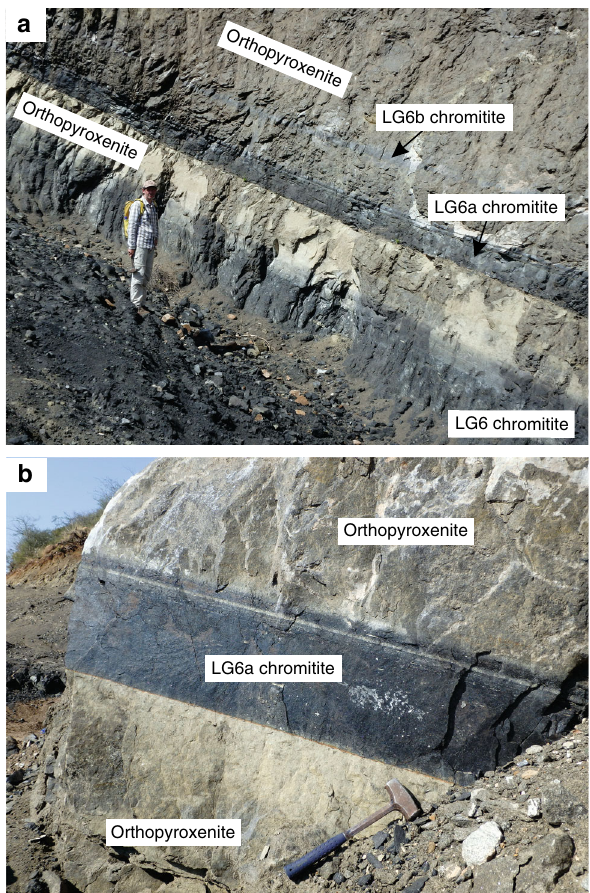
Fig. 1 Massive chromitite layers of the Bushveld Complex, South Africa. a LG6, LG6a and LG6b massive chromitites exposed in an open pit mine working from the Cameron section, Eastern Bushveld Complex. Person for scale is ~1.85 m. b A closer view of the LG6a massive chromitite within